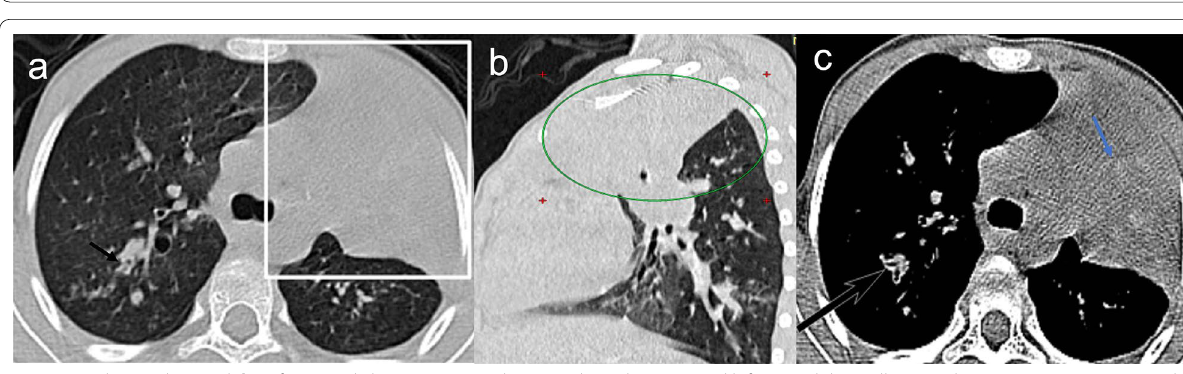
Fig. 8 Axial ( a ) and sagittal ( b ) reformatted chest CT images (lung window) showing total left upper lobar collapse, right posterior segment UL mild bronchiectasis, bronchial wall thickening, and bilateral ground-glass centrilobular nodules. Axial mediastinal window ( c ) showing left upper lobar dense internal contents of mucoceles (blue arrow), right posterior segment UL mild bronchiectasis and bronchial wall thickening (black arrows). A diagnosis of cystic fibrosis with secondary infection was established, estimated CT score was